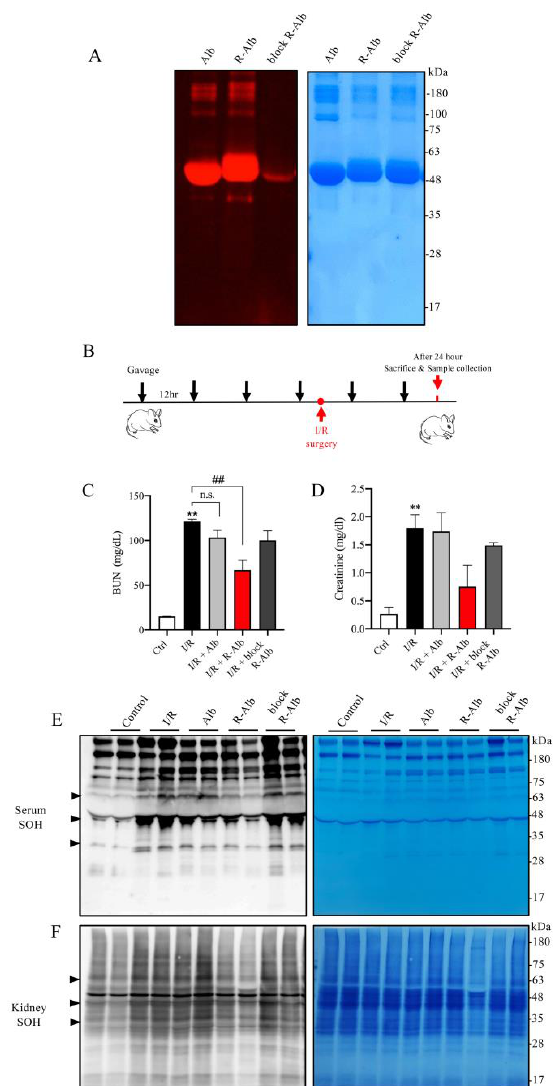
Figure 7. Reductively modified albumin attenuated renal I/R injury. ( A ) The influence of reductive modification on the -SH level in albumin. Albumin was reductively modified similarly to WP. After the modification, the changes in -SH groups were determined with a maleimide-based thiol fluorescent probe. EZ blue staining was performed to confirm the equal loading of protein. ( B ) The schematic depiction of the animal experiment design. ( C , D ) Effect of reductively modified albumin on renal function. Sera from the differently treated groups were assayed for BUN and creatinine. The results are mean ± SE ( n = 3; n.s.: not significant; ** p < 0.01 vs Ctrl; ## p < 0.01 vs. R-WP group). ( E , F ) The effect of R-Alb administration on protein oxidation. Serum and renal lysates were assayed for -SOH formation. The equal loading of proteins was verified with EZ blue staining. Note the obviously changed bands between the treated and untreated groups